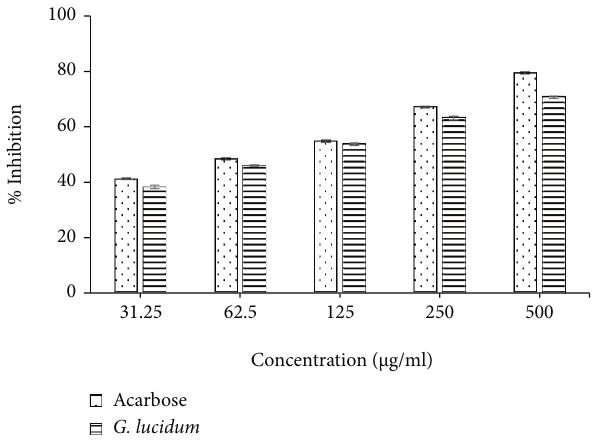
Figure 6: α -Amylase inhibitory activity of ethanolic extract of G. lucidum in comparison with the standard (Acarbose). Results are expressed as mean ± SD ( n = 3